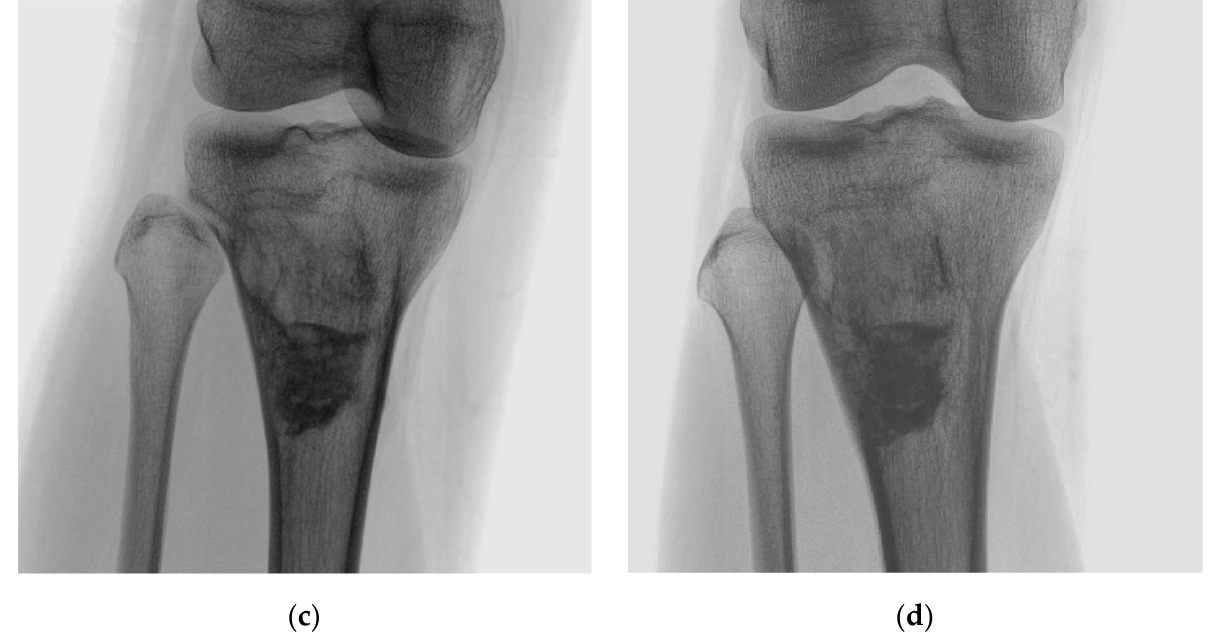
Figure 2. Preoperative coronal ( a ) and axial ( b ) T1-weighted MRI sequences, showing fibrous dysplasia in the right proximal tibial metaphysis ( Case 3 ). Anteroposterior (AP) radiographs of right knee: ( c ) at 6 months follow-up, the GeneX shows partial resorption and the fenestration site is still visible on the lateral cortex; and ( d ) at 12 months follow-up, the GeneX continues to resorb, with progressive ossification of the defect, and the lateral cortex has healed.